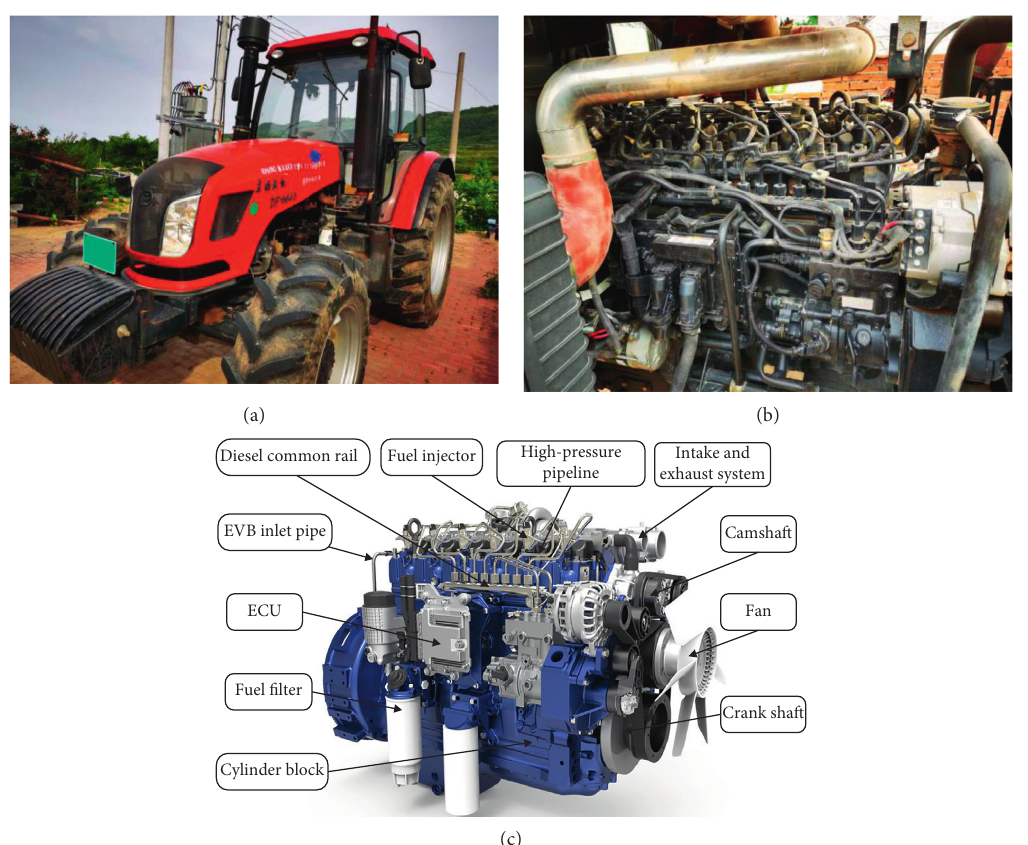
Figure 6: Schematic diagram of Dongfeng 1504-5 tractor and Weichai WP6 diesel engine. (a) Dongfeng Agricultural Machinery 1504-5 tractor. (b) Weichai WP6 diesel engine. (c) Structural diagram of Weichai WP6 diesel engine. Table 2: Sample data of diesel engine failure under different working conditions. Working